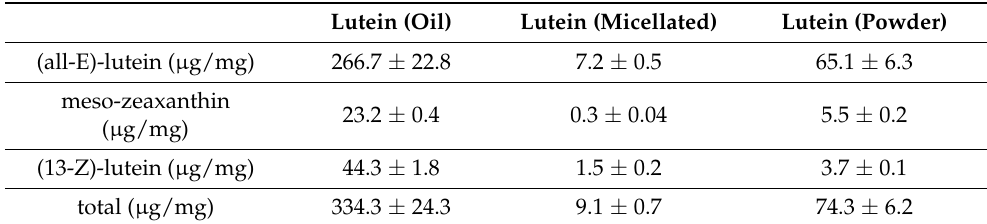
Table 2. Xantophyll content of unformulated lutein, micellated lutein and lutein powder products as determined by HPLC-DAD.